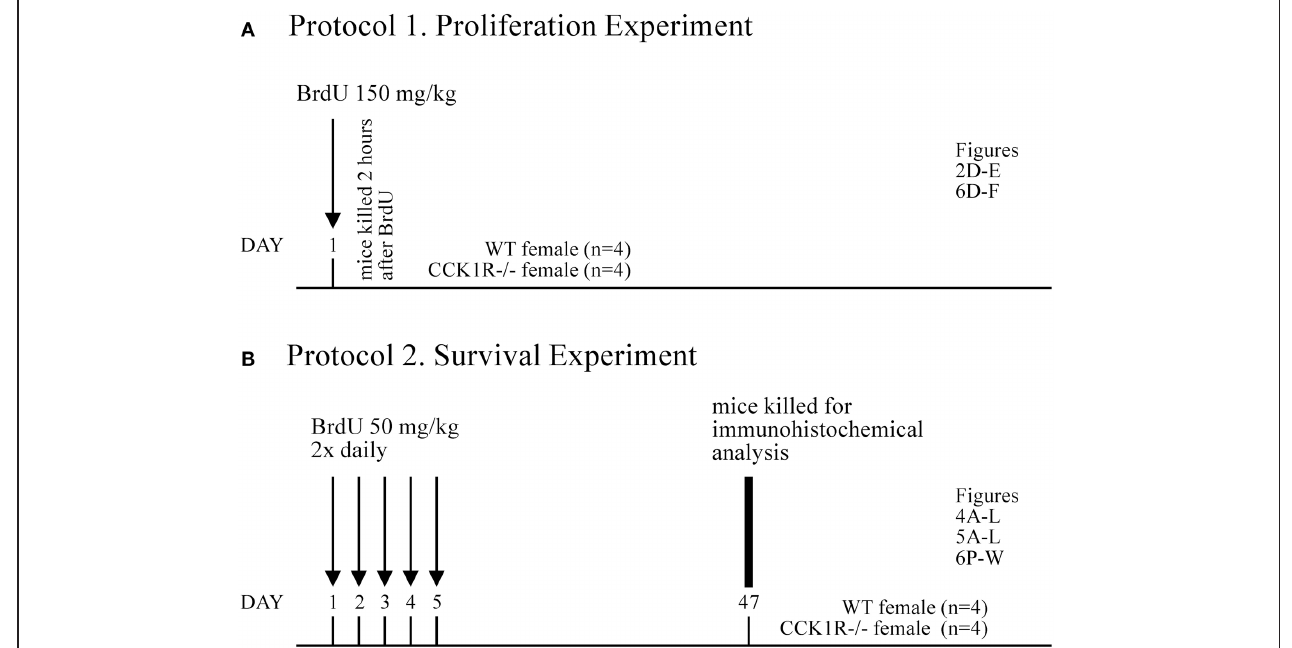
FIGURE 1 | BrdU Experimental Design. (A) Protocol 1 . To identify proliferating cells in the SVZ and SGZ, a single dose of BrdU (150mg/kg i.p.) was administered 2h prior to death ( n = 4 for each experimental group). From these animals, the number of BrdU + cell bodies in